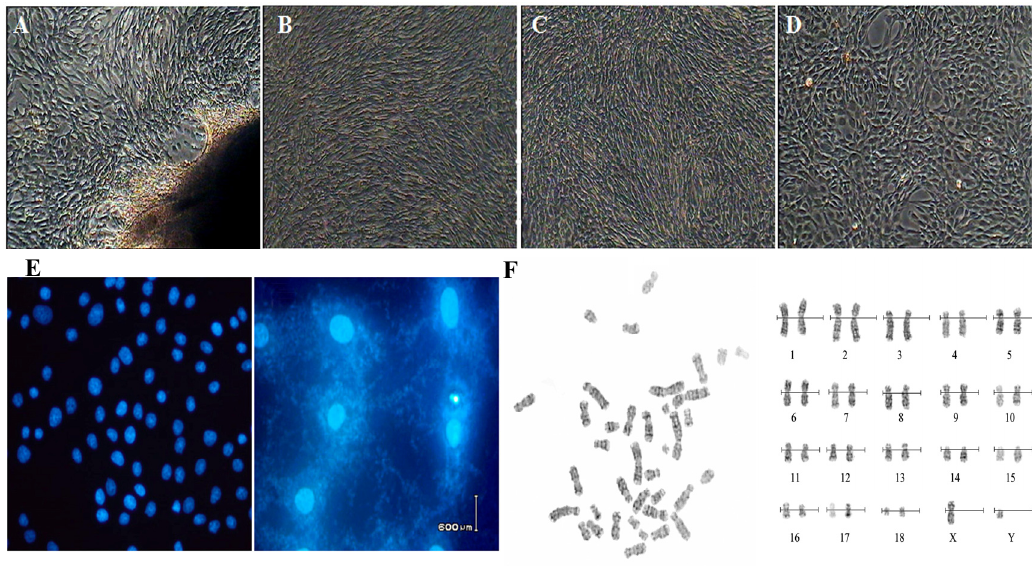
Figure 1. Morphology, Mycoplasma contamination and karyotype of Bengal tiger cell